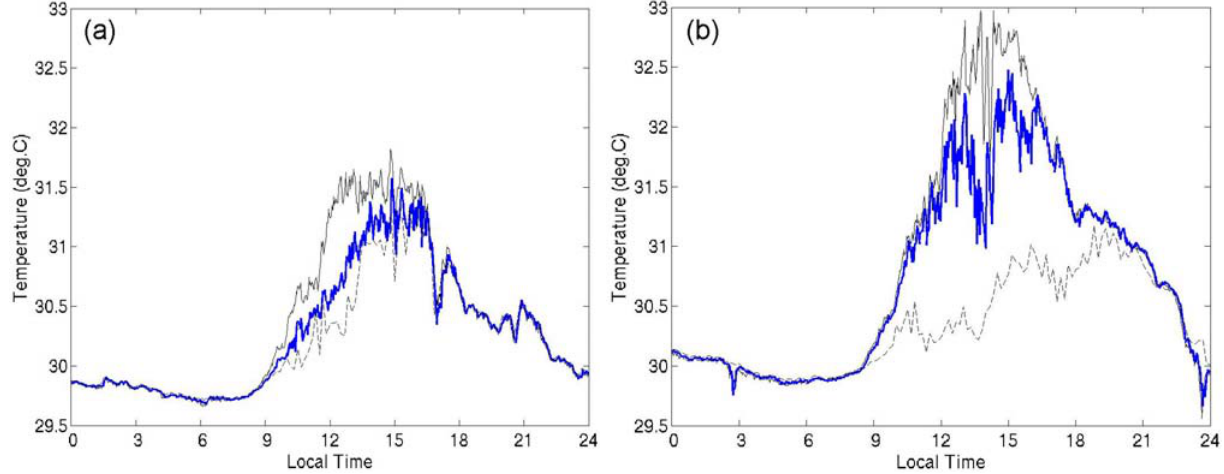
Figure 5. Temperature variations at 0.2 m depth on (a) 8 April 2005 and (b) 16 May 2005. Solid black line: measurements on the mark side of the hull; blue line: opposite side; broken black line: CT sensor at 1.5 m depth. The sampling interval of the CT sensor was 10 minutes; the others were 2